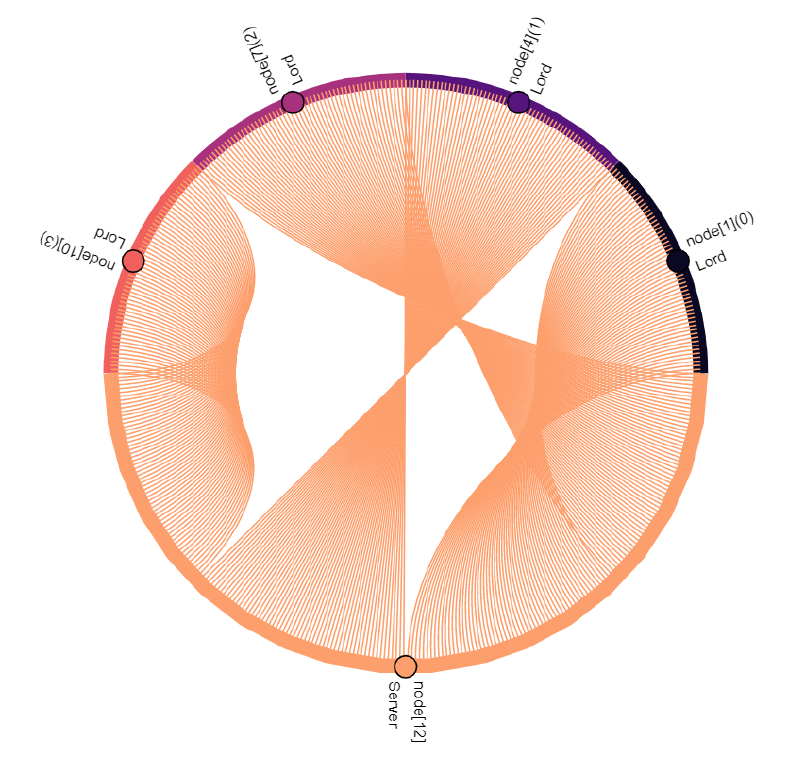
Figure 12. The server replies to the requests of the lords shown in Figure